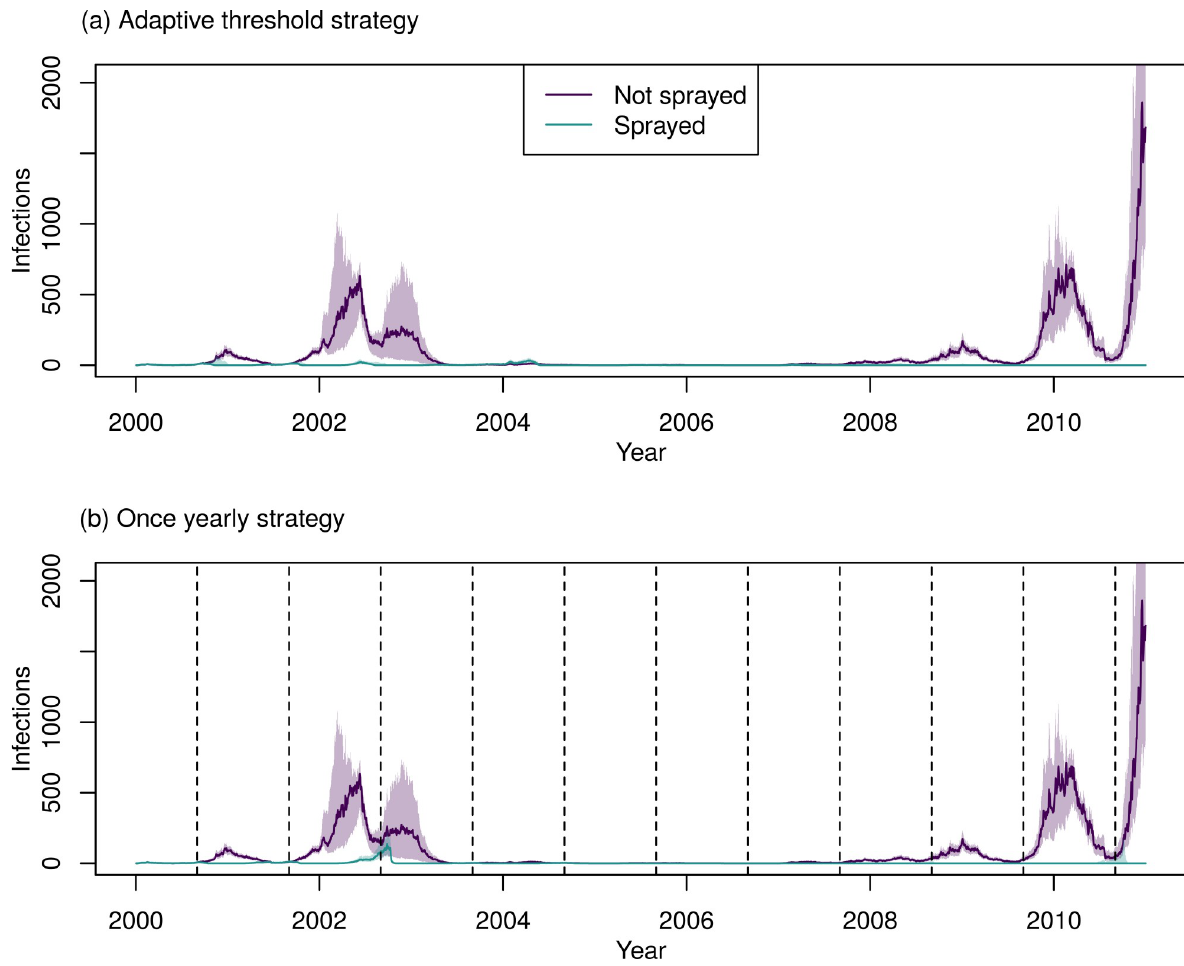
Fig 9. Time-series of incidence of human infections for the best TIRS strategy in each category, for (a) an adaptive strategy and (b) a yearly strategy. In each plot the purple lines represent the predictions without spraying, and the green represents the given strategy. The line represents the median of all 400 simulations and the shading represents the inter-quartile range. The vertical dotted lines represent the start of city-wide TIRS campaigns (not displayed for the threshold strategy as in this case campaigns start at differing times depending on incidence).